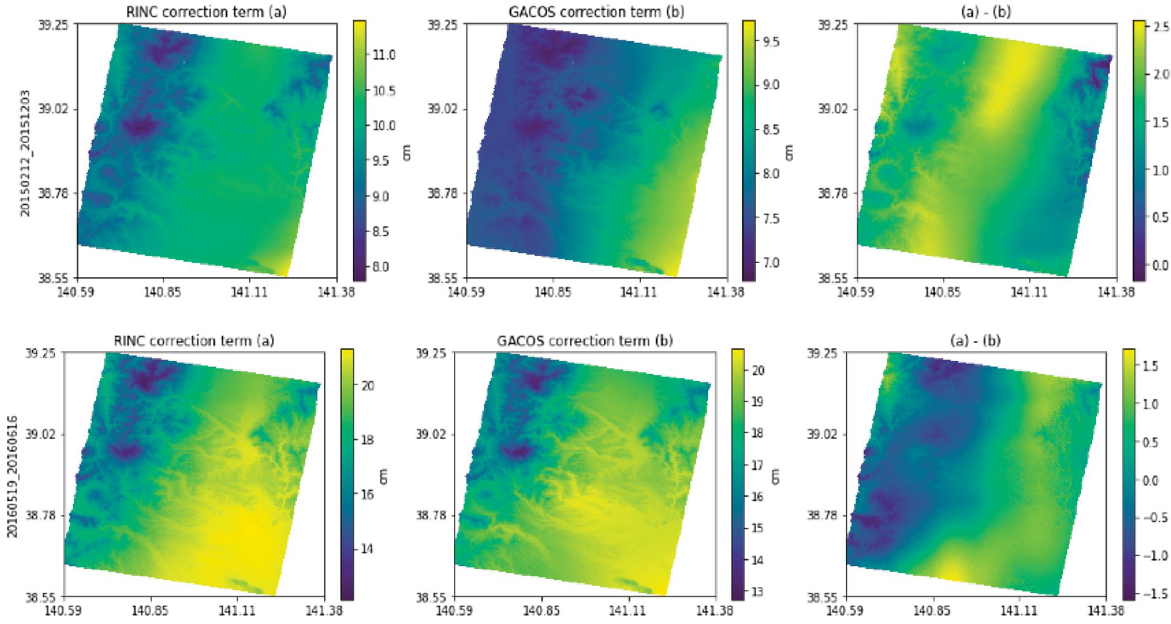
Fig. 7 Correction terms from RINC and GACOS and the differences between the two methods were calculated for two interferograms in the Tohoku region. The acquisition dates are shown on the left side of the figures